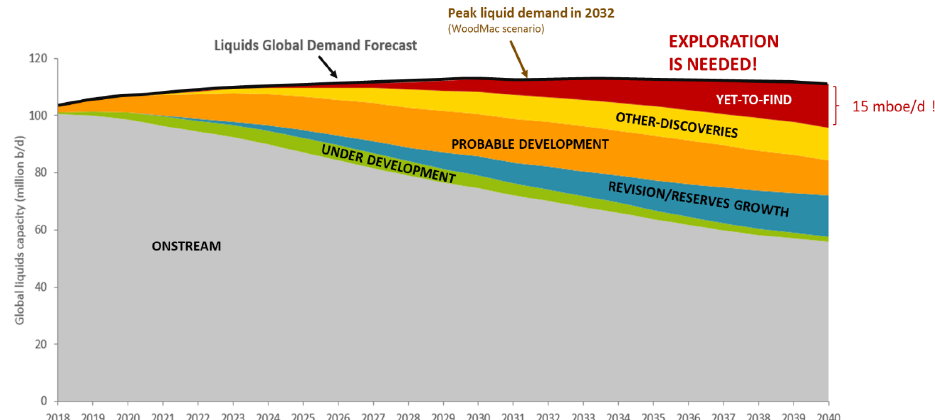
Fig. 12. – The need of new discoveries (from [3]).